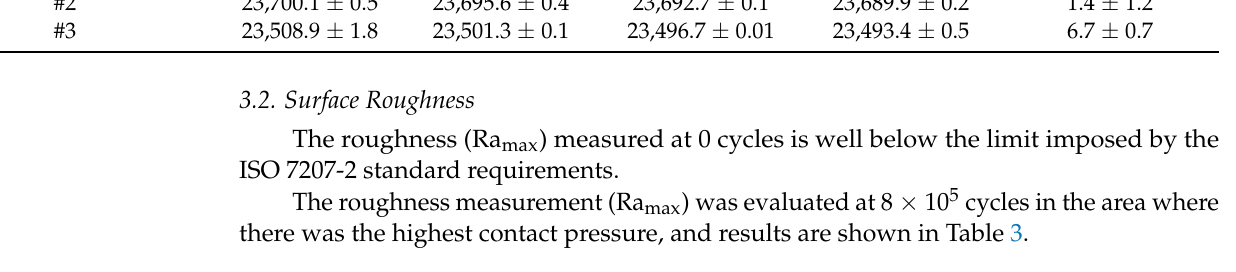
Table 3. Mean femoral and tibial specimens’ roughness ( ± standard deviation).